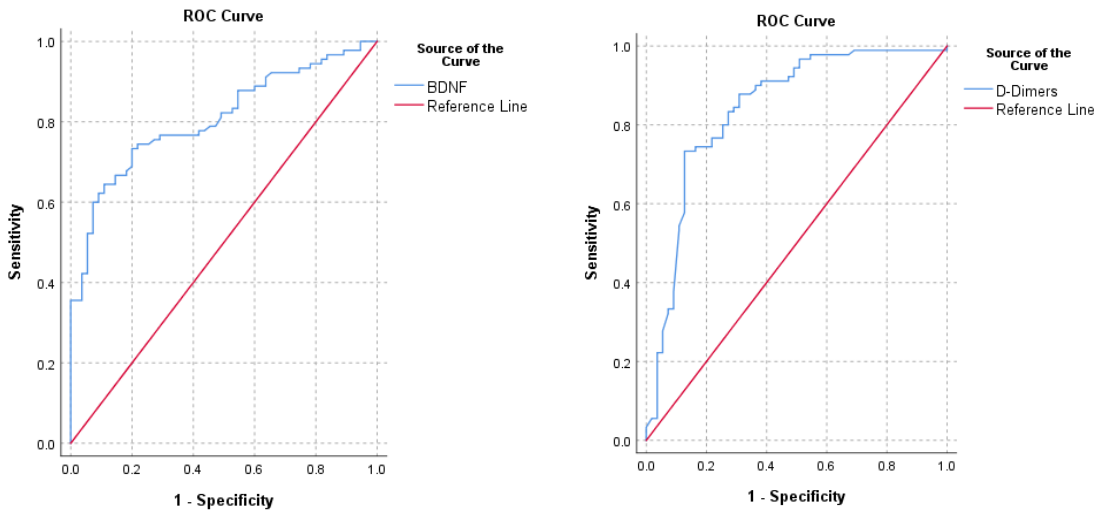
Figure 1. Receiving operating characteristics curves (ROC) for D-dimers and BDNF. Table 5. Binary logistic regression of BDNF and D-dimers for diagnostic of